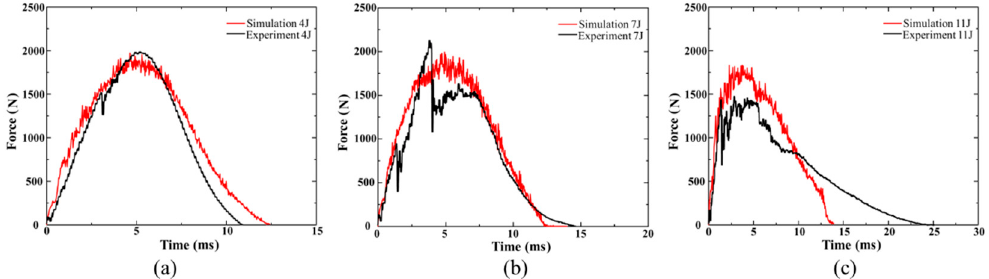
Figure 6. Comparison of numerical and experimental impact force–time curves of UACS laminates under impacts at ( a ) 4 J, ( b ) 7 J and ( c ) 11 J.